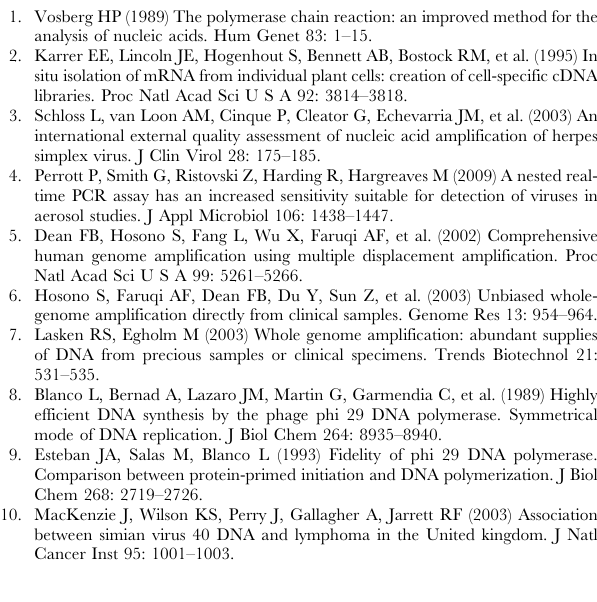
Figure S1 Over-saturated samples in Figure 3 demon- strate typical sigmoid curves. Multicomponent view of over-saturated curves from Figure 3, demonstrating typical sigmoid curves with a Ct-value of 3–4.